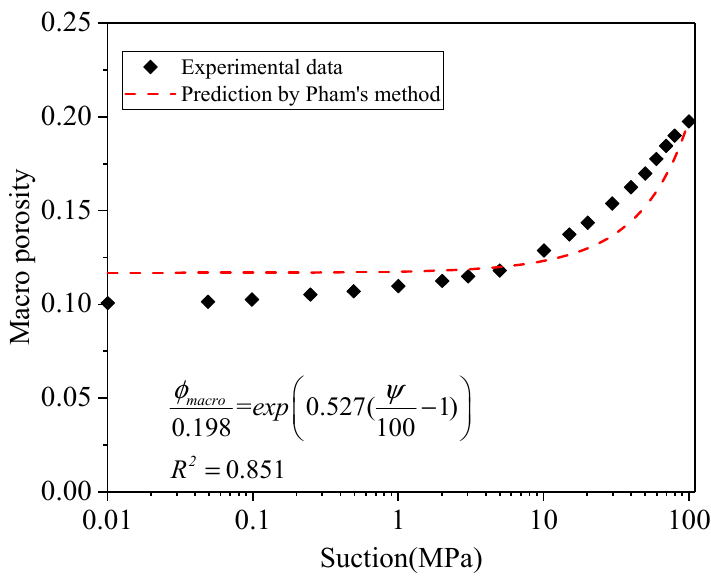
Figure 7. Relationship between macro porosity and suction. Since the Ψ ref (100 MPa) is obtained by extending the trend of the experimental curve, it could be slightly different from the real value of Ψ ref ; therefore, a small correction term ( C × Ψ / Ψ ref ) is introduced into Equation (38), yielding Equation (46), which reduces the deviation caused by the assumed Ψ ref . If Ψ ref can be measured accurately, the small correction term can be considered as zero, which has been proved by Liu et al. [23].